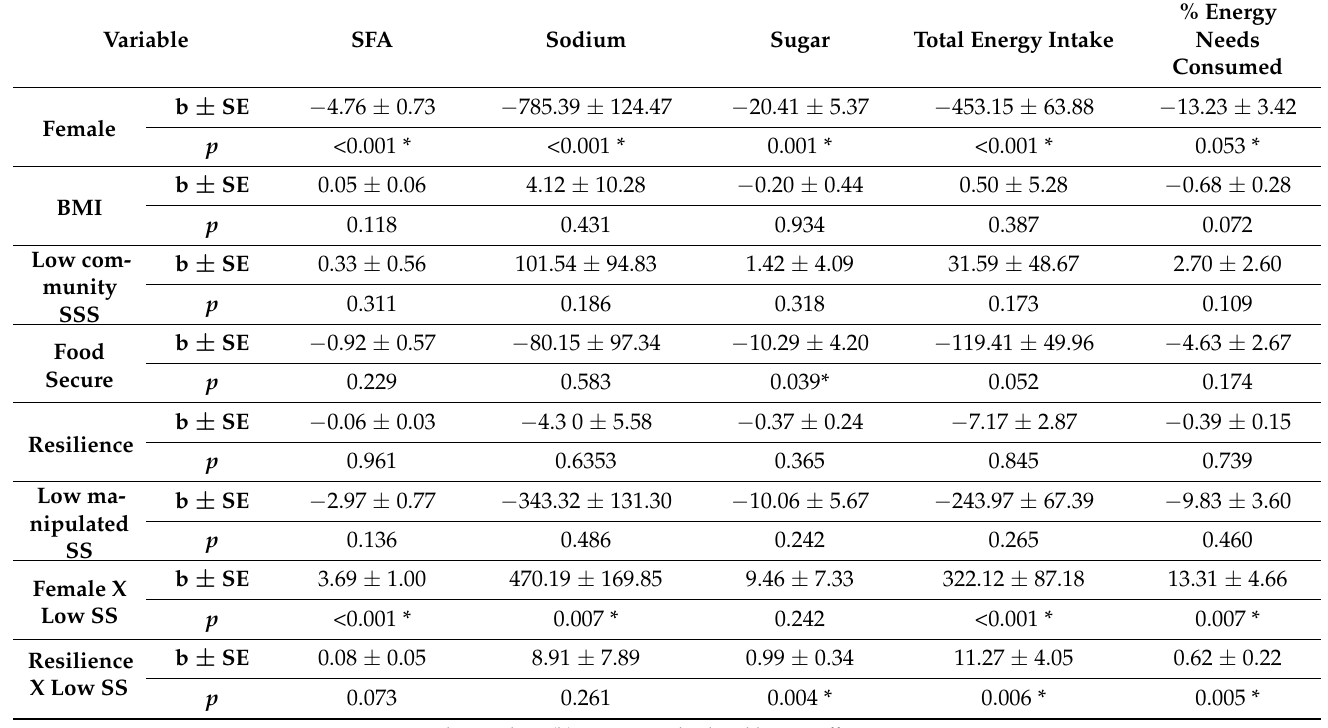
Table 2. Regression coefficients and p -values for each dietary outcome variable.